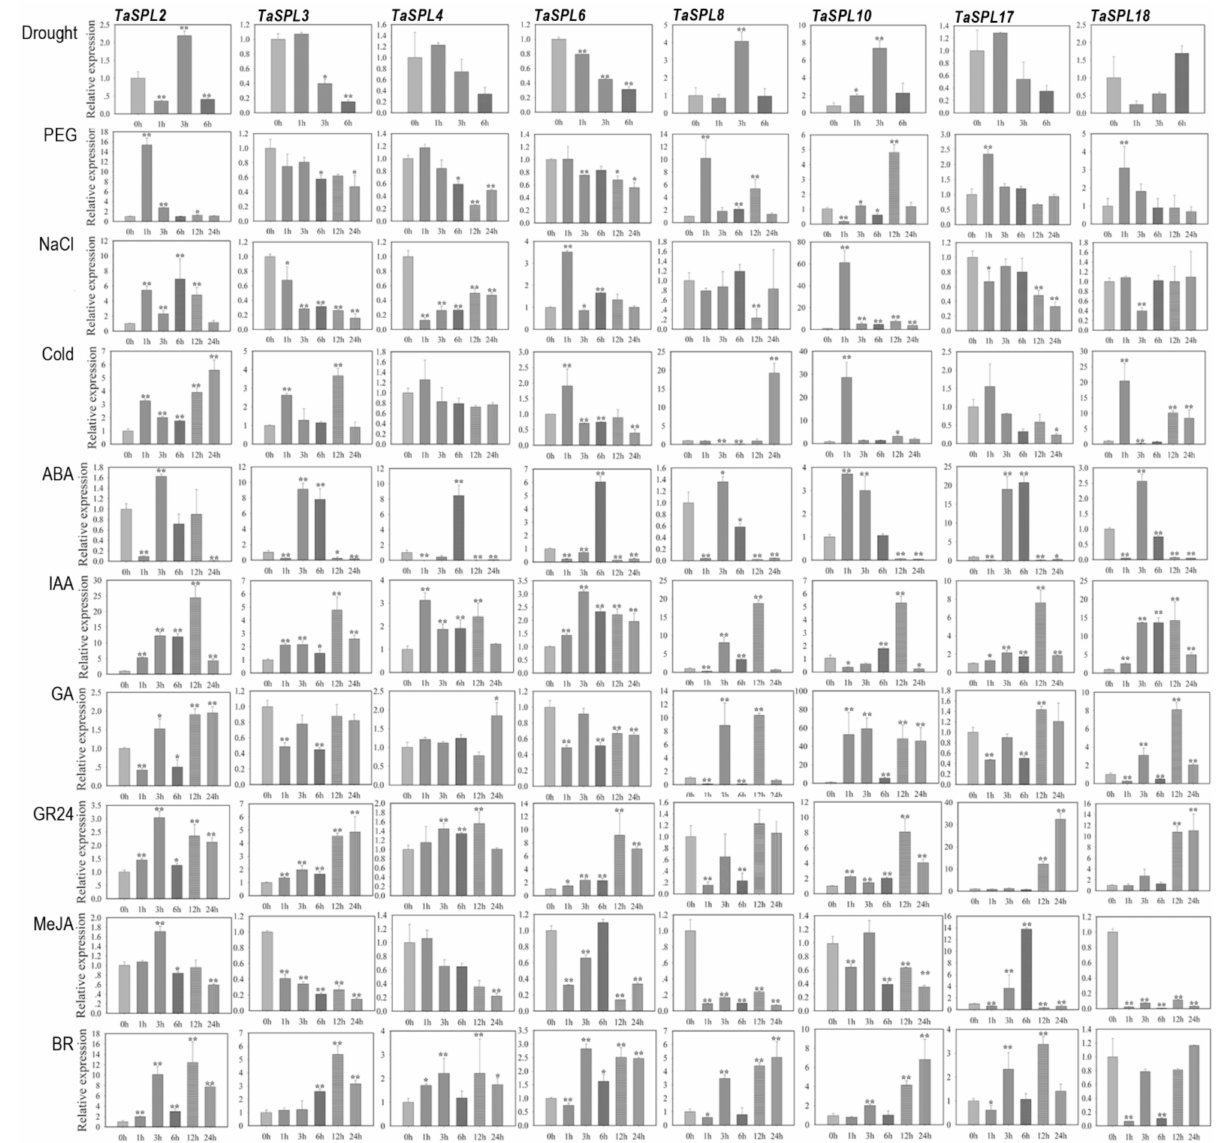
Figure 4. Spatial–temporal expression preference of TaSPL s and their responses to abiotic and phytohormone treatments, as determined by qPCR. Temporal expression profiles of TaSPL2 , TaSPL3 , TaSPL4 , TaSPL6 , TaSPL8 , TaSPL10 , TaSPL17, and TaSPL18 at 0, 1, 3, 6, 12, and 24 h after the treatments of abiotic stresses or phytohormones. Significant differences in expression levels were